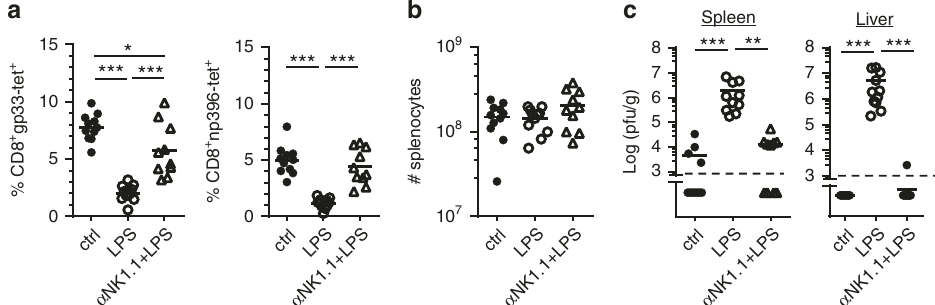
Fig. 2 LPS treatment leads to NK cell-mediated impairment of the anti-LCMV CTL response. NK cell-depleted and non-depleted B6 mice were infected with LCMV. After one day of infection, they received LPS or PBS as a control (ctrl). Mice were analyzed at day 8 after LCMV infection. a gp33- and np396- tetramer + (tet) CD8 T cells in percent of spleen cells. b Absolute numbers (#) of splenocytes. c Viral titers in spleen and liver. Data of individual mice ( n = 11) from 4 to 5 independent experiments with 2 – 3 mice per group are shown; horizontal bars represent the mean values. Dashed lines indicate detection limits. * p < 0.05, ** p < 0.01, *** p < 0.001; one-way ANOVA with Tukey-Kramer post-test ( a , b ) or Kruskal – Wallis Test with Dunn ’ s post-test ( c ) LCMV-induced expansion of P14 T cells in IL-15-de fi cient mice did not interfere with the initial priming of the CTL response. In (Fig. 3d). sharp contrast to this, one day later (day 5 p.i.), frequencies and Regulation of T-cells by NK cells frequently operates through absolute numbers of clonally expanded P14 T-cells were con- cell-mediated lysis via perforin 16,17,30 . To determine whether the siderably lower in LPS-treated mice compared to controls (Fig. 3b). As in the polyclonal setting, the LPS-induced decrease decrease in expansion of P14 T-cells by LPS was perforin- in P14 T-cell expansion was prevented by NK cell depletion dependent, perforin-de fi cient mice were used as recipients of P14 (Fig. 3c). To con fi rm the importance of NK cells for the decreased T cells. Unlike to wt recipients, LPS did not decrease the LCMV- expansion of P14 T cells after LCMV infection and LPS treat- induced expansion of P14 T-cells in hosts lacking perforin ment, IL-15-de fi cient mice were used as recipients of P14 T cells. (Fig. 3e). For the LCMV clone 13 infection model, it was These mice almost completely lack NK cells but mount a fully postulated that NK cells negatively regulate T cell priming by cell- functional CTL immune response after LCMV infection 29 . In mediated lysis of antigen presenting cells (APC) 19 . The unaltered contrast to wt recipient mice, LPS injection did not lower the initial P14 T cell expansion until day 4 p.i. (Fig. 3a), however,